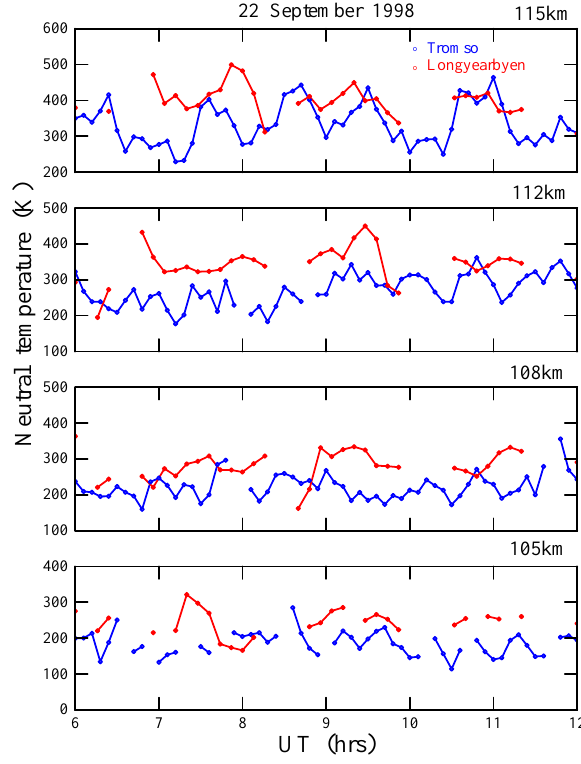
Fig. 9. Electron (black) and ion (red) temperatures at Longyearbyen obtained by the field-aligned beams between 105 and 115km from 06:00 to 12:00UT on 22 September 1998 (left) and 9 March 1999 (right).